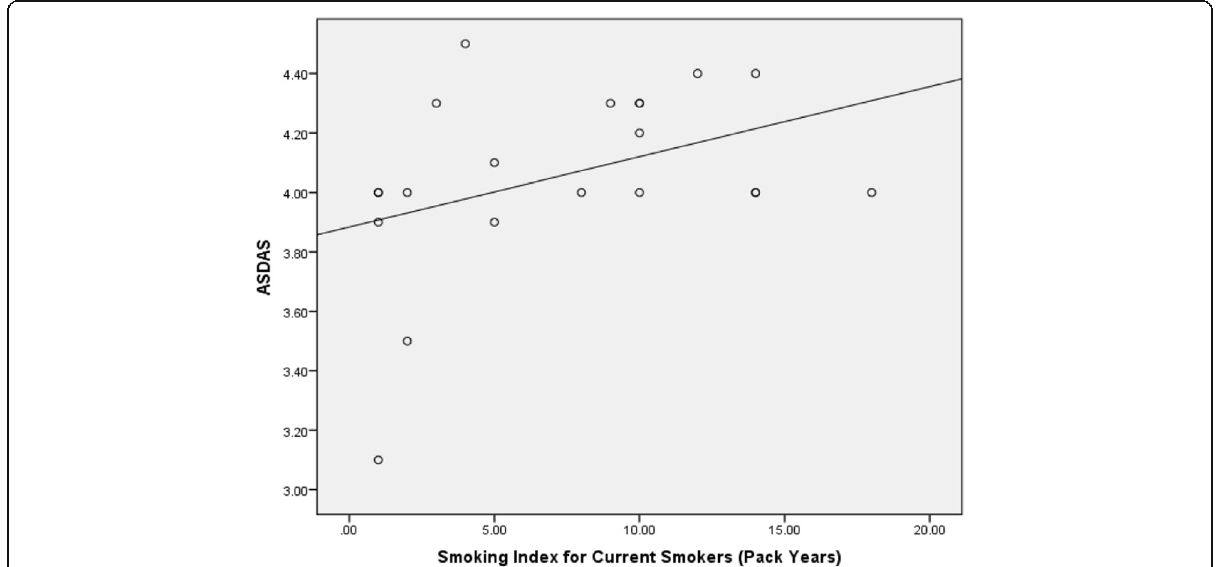
Fig. 2 Correlation between smoking index and ASDAS in AS patients. ASDAS: Ankylosing Spondylitis Disease Activity Score